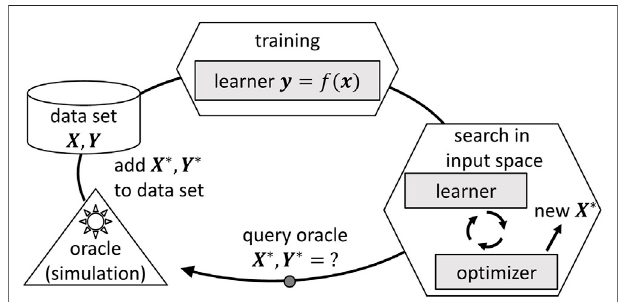
FIGURE 1 | Iterative procedure of membership query synthesis, cf. Settles (2012).